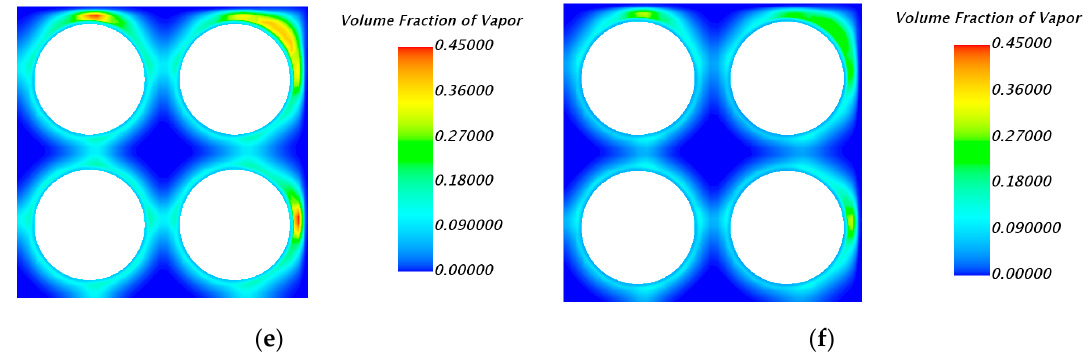
Figure 13. Volume fraction distribution on the cross-section with a height of 580 mm: ( a ) Case 1, ( b ) Case 2, ( c ) Case 3, ( d ) Case 4, ( e ) Case 5, and ( f ) Case 6.